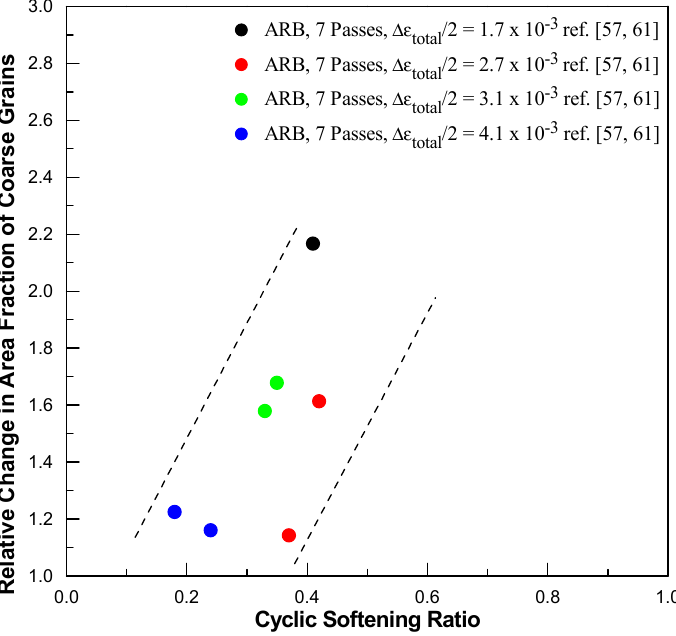
Figure 1. A plot illustrating the correlation between the observed cyclic softening ratio according to [24] and the occurrence of grain coarsening upon cyclic loading of ARBed